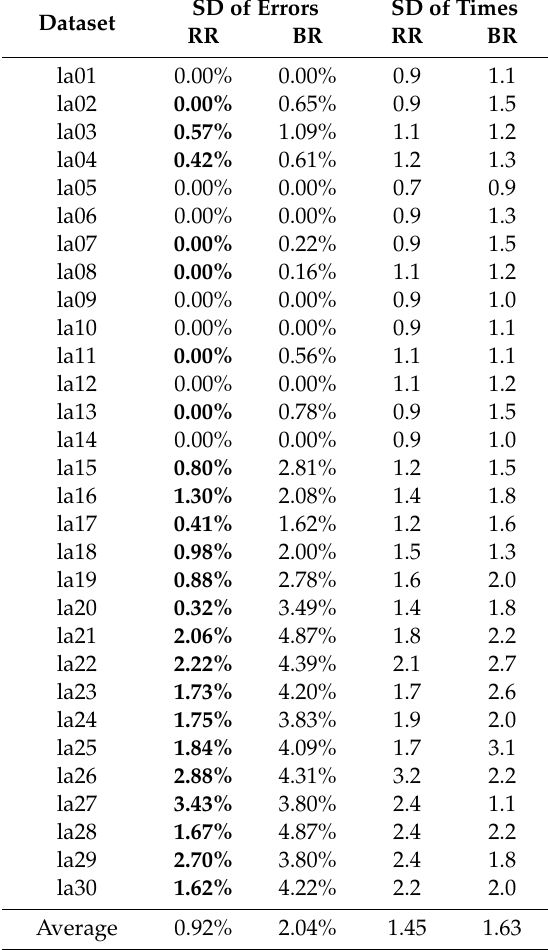
Table 4. Standard deviations of error and times obtained for the analyzed JSSP datasets solved with di ff erent sets of